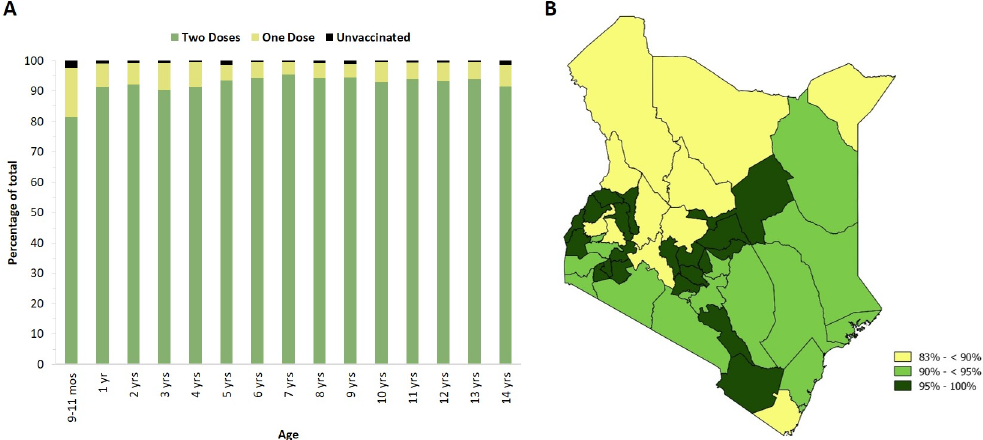
Fig 3. Estimated coverage with two doses of measles-containing vaccine (MCV) after the 2016 measles-rubella (MR) campaign in Kenya. (A) Graph of the number of MCV doses received by one-year age cohort, including the MCV1 and MCV2 doses provided by routine immunization services, the MR campaign dose, and previous measles campaign doses as documented by vaccination cards, campaign finger-markings and caregivers’ recall. (B) Map of two-dose MCV coverage of children aged 9 months–14 years by